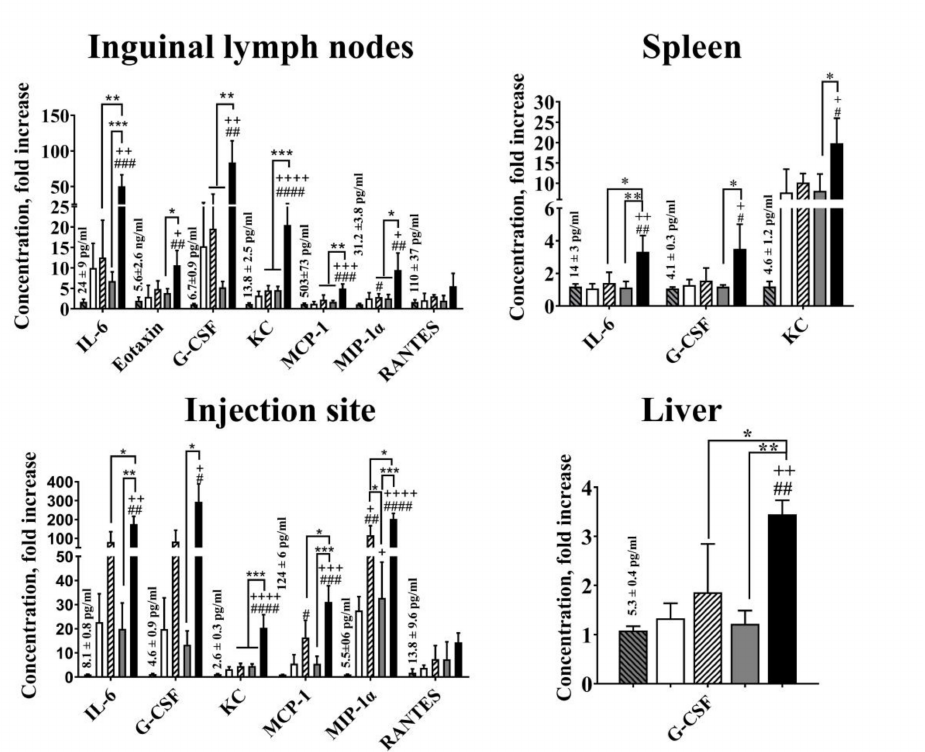
Figure 6. PLGA NPs containing both MPLA and MDP induce a stronger local cytokine response in mice than NPs containing individual PRR agonists. BALB / c mice were intramuscularly injected with 1 mg / dose of PLGA-HA, PLGA-HA-MPLA, PLGA-HA-MDP, or PLGA-HA-MPLA + MDP. Non-immunized control mice received PBS. Three hours later, inguinal lymph nodes, the liver, the spleen, and the thigh muscle (corresponding to the injection site) were isolated. Cytokine levels were measured in tissue homogenates using bead-based immunoassay. Control mice were injected with PBS. Results are expressed as the mean fold change in cytokine concentration relative to the mean concentration in PBS-treated control animals. Values of control group (mean concentrations ± SD are indicated above the bars) were taken equal to 1 (100%). Each point represents the mean of three mice per group ± SD (error bars). Significant di ff erences between PLGA NPs and intact cells are indicated by hashes: # for p < 0.05, ## for p < 0.01, ### for p < 0.001, or #### for p < 0.0001. Significant di ff erences between PLGA NPs with or without PRR agonists are indicated by plus: + for p < 0.05, ++ for p < 0.01, +++ for p < 0.001, or ++++ for p < 0.0001. Significant di ff erences